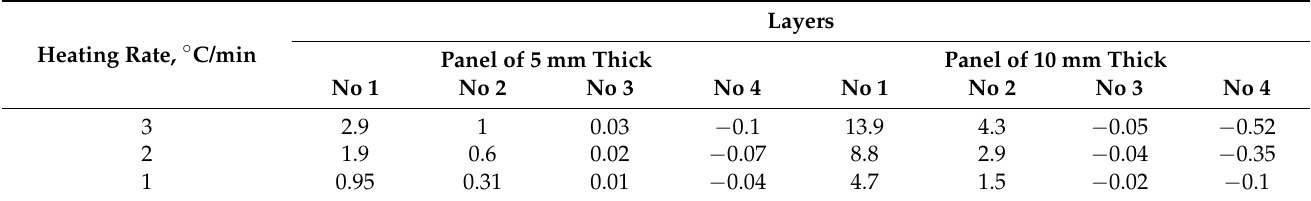
Table 2. Dependence of maximum stresses (MPa) in the layers of sandwich panel on the heating rate. Layers Heating Rate, ◦ C/min Panel of 5 mm Thick Panel of 10 mm Thick